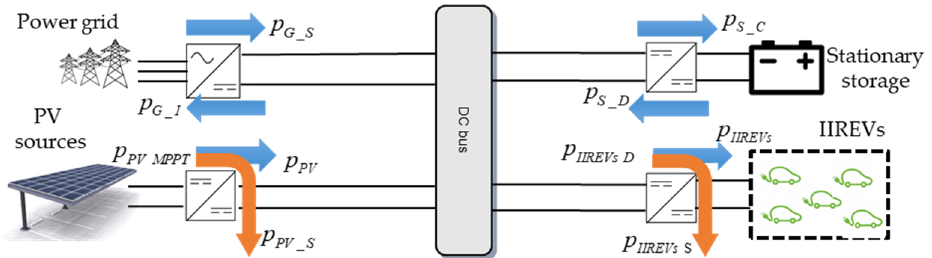
Figure 1. Power flow for the intelligent infrastructure for recharging EVs.